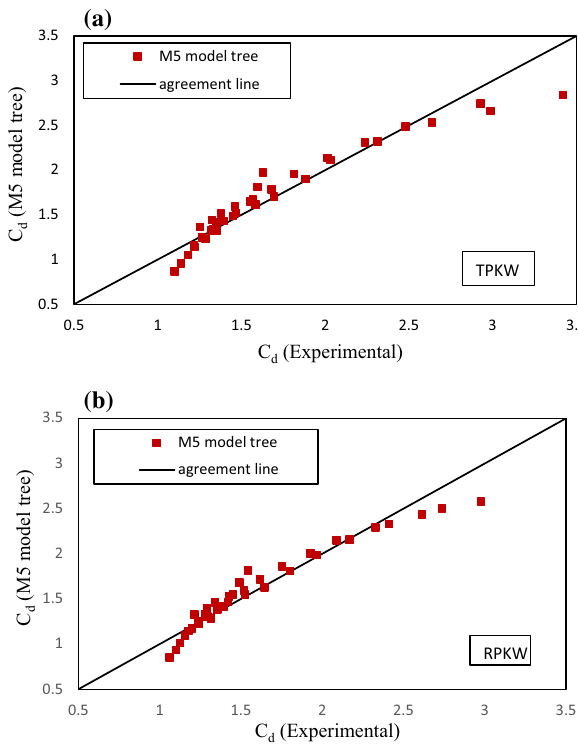
Fig. 9 Experimental versus predicted values of Cd using M5 tree method for a trapezoidal, and b rectangular PK weirs